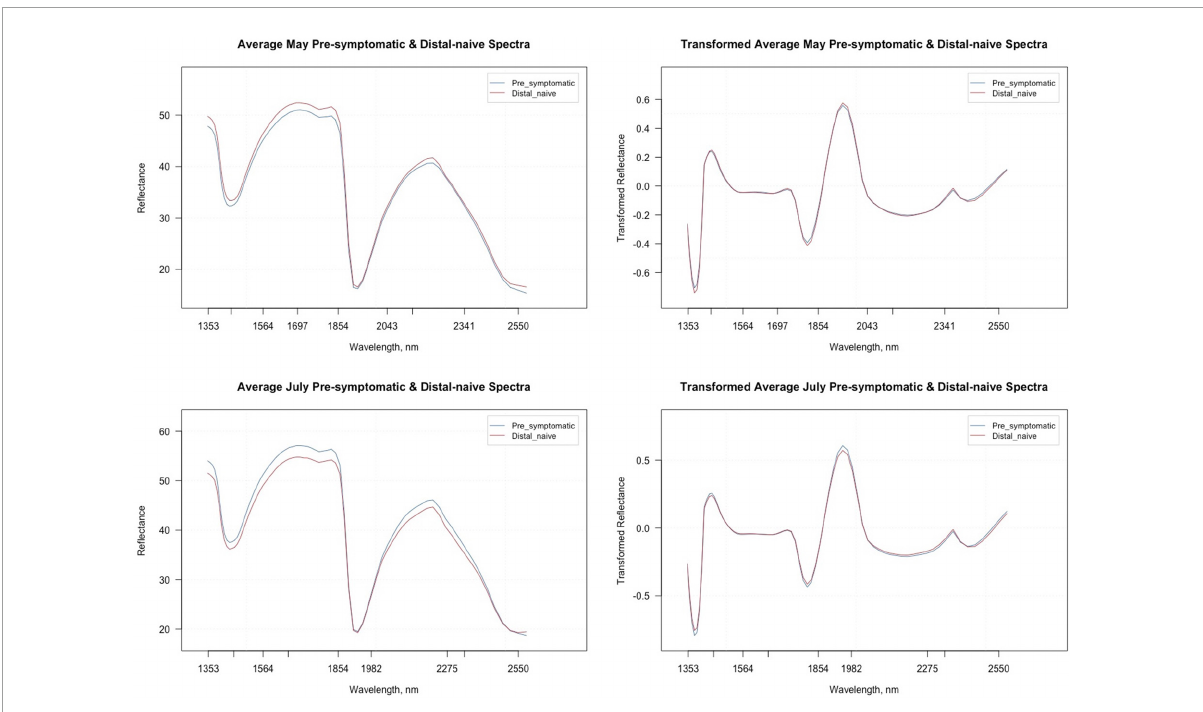
FIGURE2 Average raw and second derivative transformed spectral signatures of pre-symptomatic (excluding the Kiwanis site) and distal-naïve samples in May and